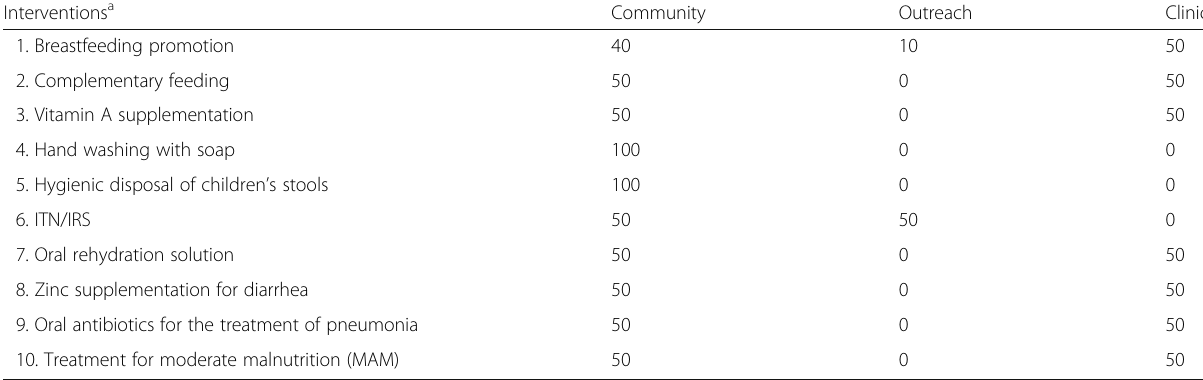
Table 2 Percent of each intervention delivered at each level of healthcare delivery channels across EAC Interventions a Community